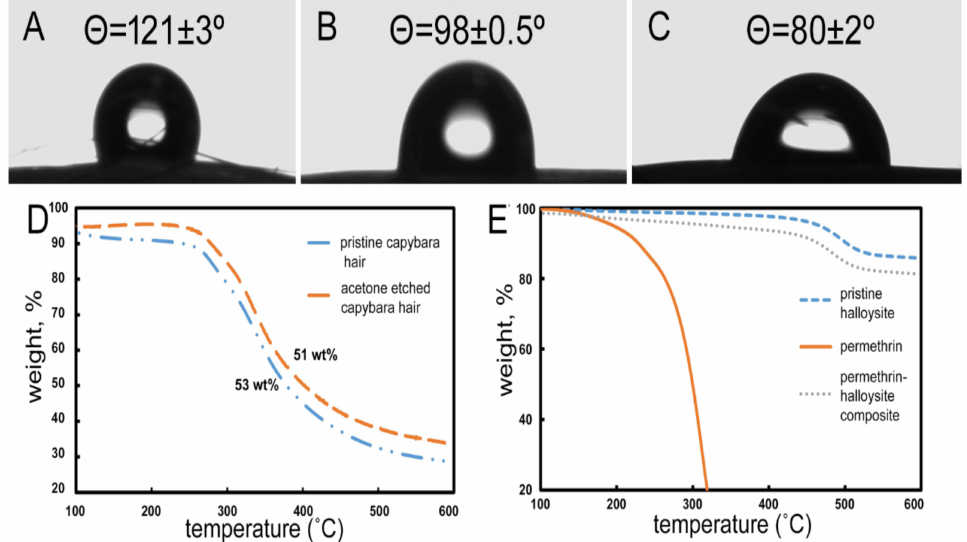
Figure 5. Water contact angle on pristine capybara hair ( A ), guinea pig ( B ), and acetone treated (unwaxed) capybara hair ( C ); thermogravimetric analysis of capybara pristine and acetone etched hair ( D ); and of permethrin, pristine halloysite, and permethrin-halloysite composite ( E ).